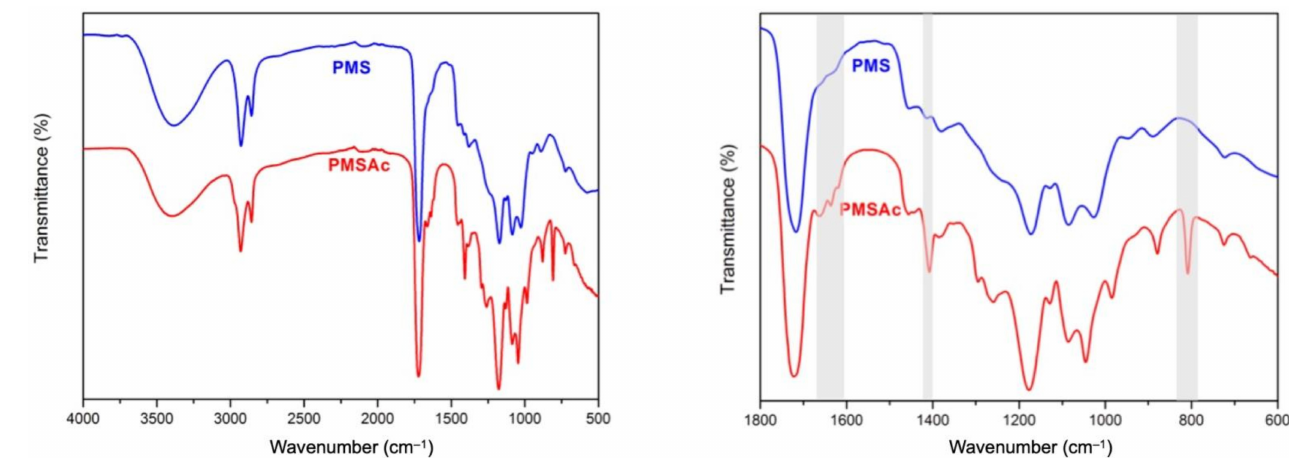
Figure 2. Right side: complete ATR–FTIR spectra of the PMS and PMSAc. Left side: magnified view of the 1800—600 cm − 1